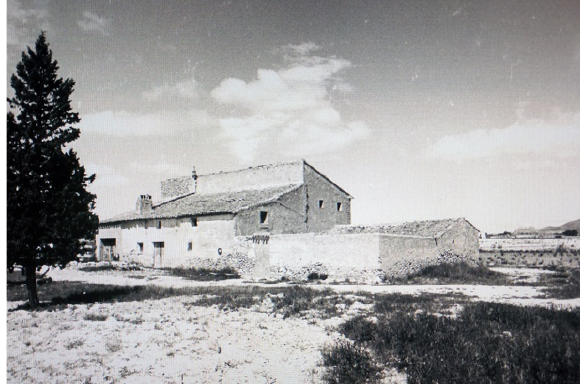
Figure 23. Mas de la Parrotja in 1984 when the building was